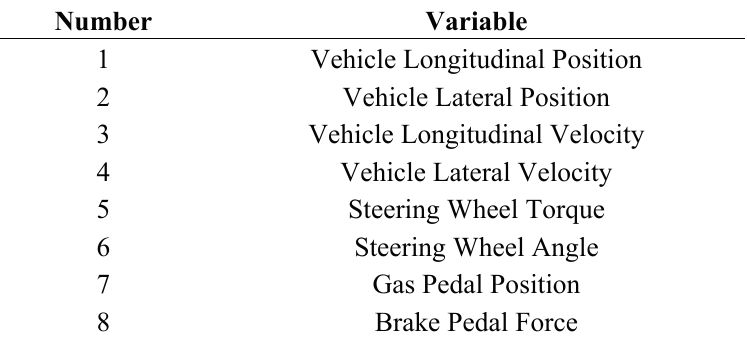
Table 2 . Recorded vehicle dynamics